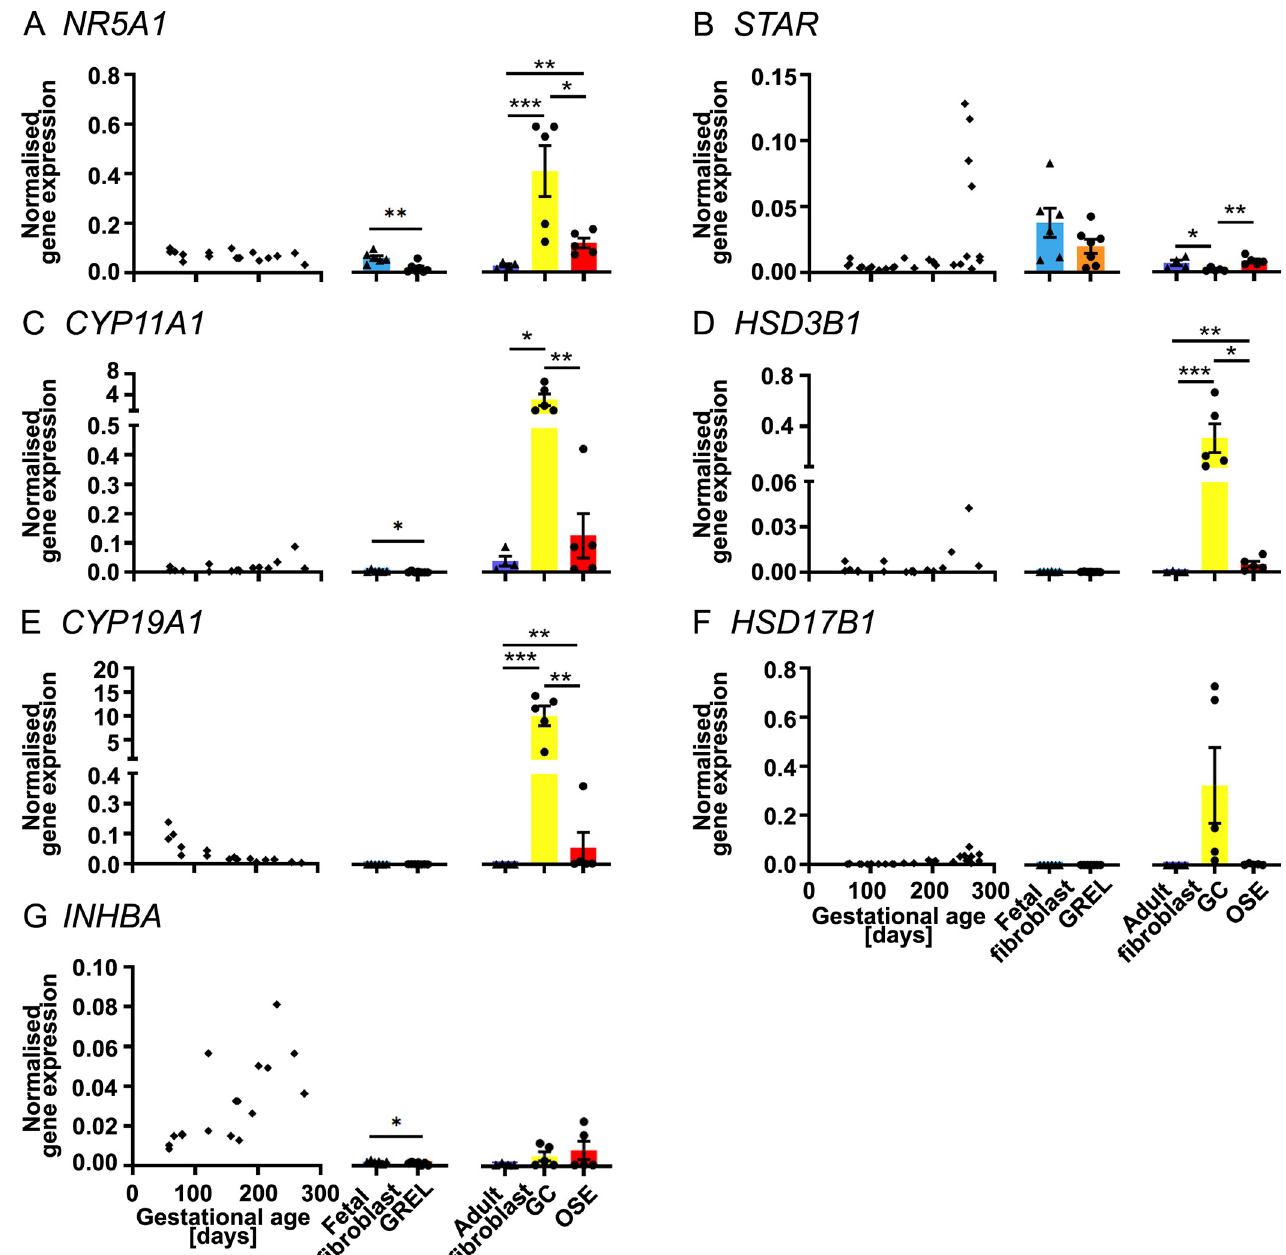
Fig 4. mRNA expression levels of genes involved in hormone production. Scatter plots in each subfigure show gene expression levels in fetal ovaries at different gestational ages (n = 27), and scatter plots for NR5A1 (A), CYP11A1 (C), HSD3B1 (D), CYP19A1 (E) and INHBA (G) are from our previous publications [30, 31]. Gene expression levels in cultured GREL cells (n = 7; gestational ages are 51, 56, 73, 110, 110, 127 and 177 days) and fetal fibroblasts (n = 6; gestational ages are 51, 73, 101, 110, 110 and 177 days) are presented as mean ± SEM (normalised to PPIA and RPL32 ) in the middle graph of each subfigure. The differences between GREL cells and fetal fibroblasts were analysed with Student’s t-tests. Data of gene expression in adult fibroblasts (n = 4), granulosa cells (GC; n = 5) and ovarian surface epithelium (OSE; n = 5) are presented as mean ± SEM (normalised to PPIA and RPL32 ) in the graph on the right side of each subfigure. Significant differences among the three adult cell types were determined by one-way ANOVA with Tukey’s post-hoc test. � P < 0.05, ��� P <